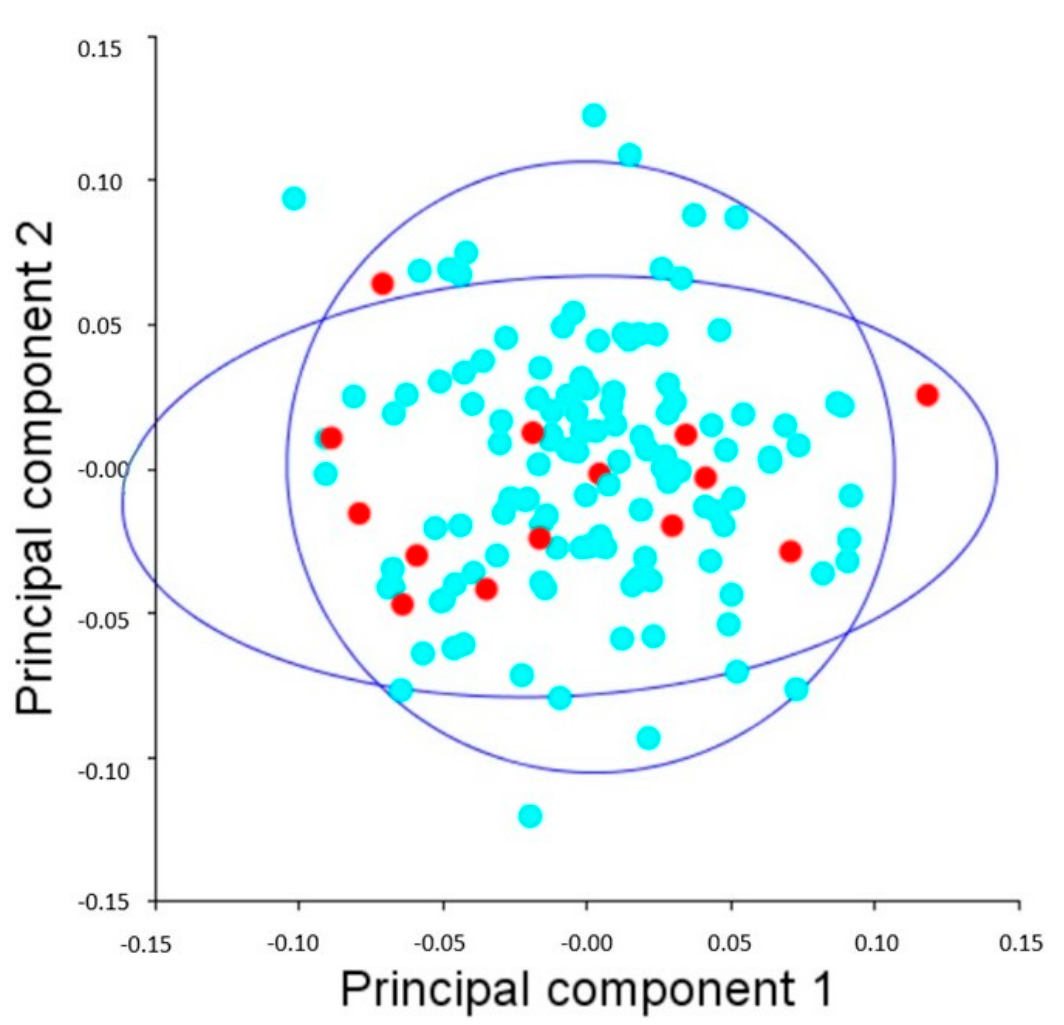
Figure 2. Space–shape PCA for 135 adult animals (14 mares, red points; and 121 geldings, blue points, red and blue points: aggregat) belonging to the Araucanian horse breed. The first two PCs account for 65.6% of the total variance (PC1 + PC2 = 35.20% + 30.46%). It showed a considerable degree of overlap between the sexes. Table 1. Results of the modularity analysis by the Escoufier RV coefficient (10,000 rounds of random- ization) for the different profile units studied.